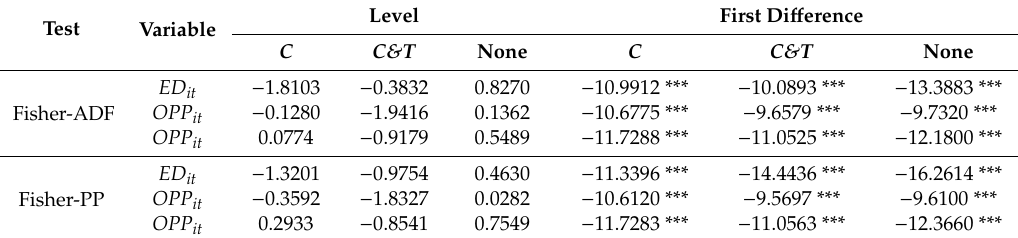
Table 4. Panel unit root